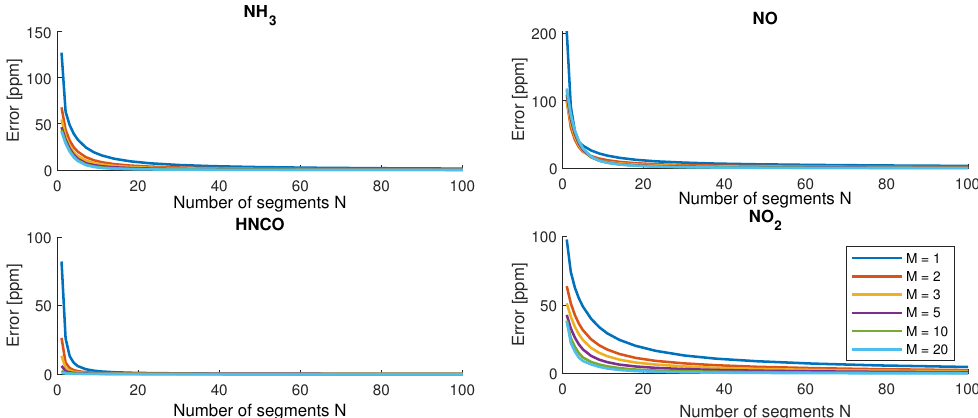
Figure 5. Maximal instantaneous error in output concentrations for different numbers of N and M . Results from simulation with N = 100 and M = 20 are used as